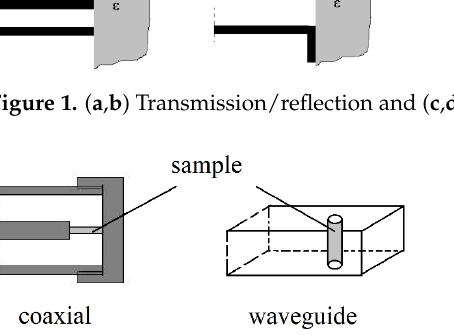
Figure 2. Reflection cells intended for measurements of high permittivity materials.